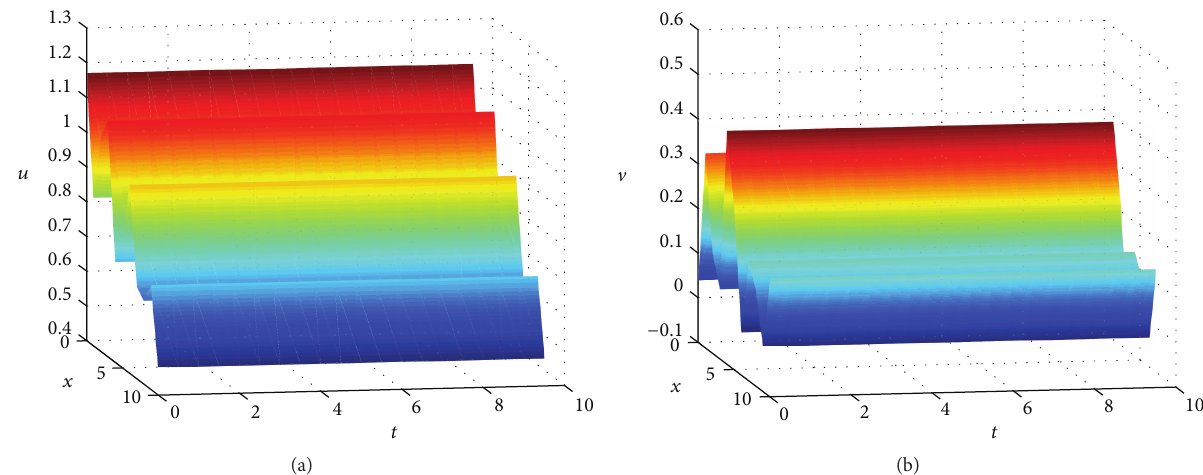
Figure 1: Numerical simulation for (5) with 𝑢 0 = cos (𝑥/10), V 0 = cos